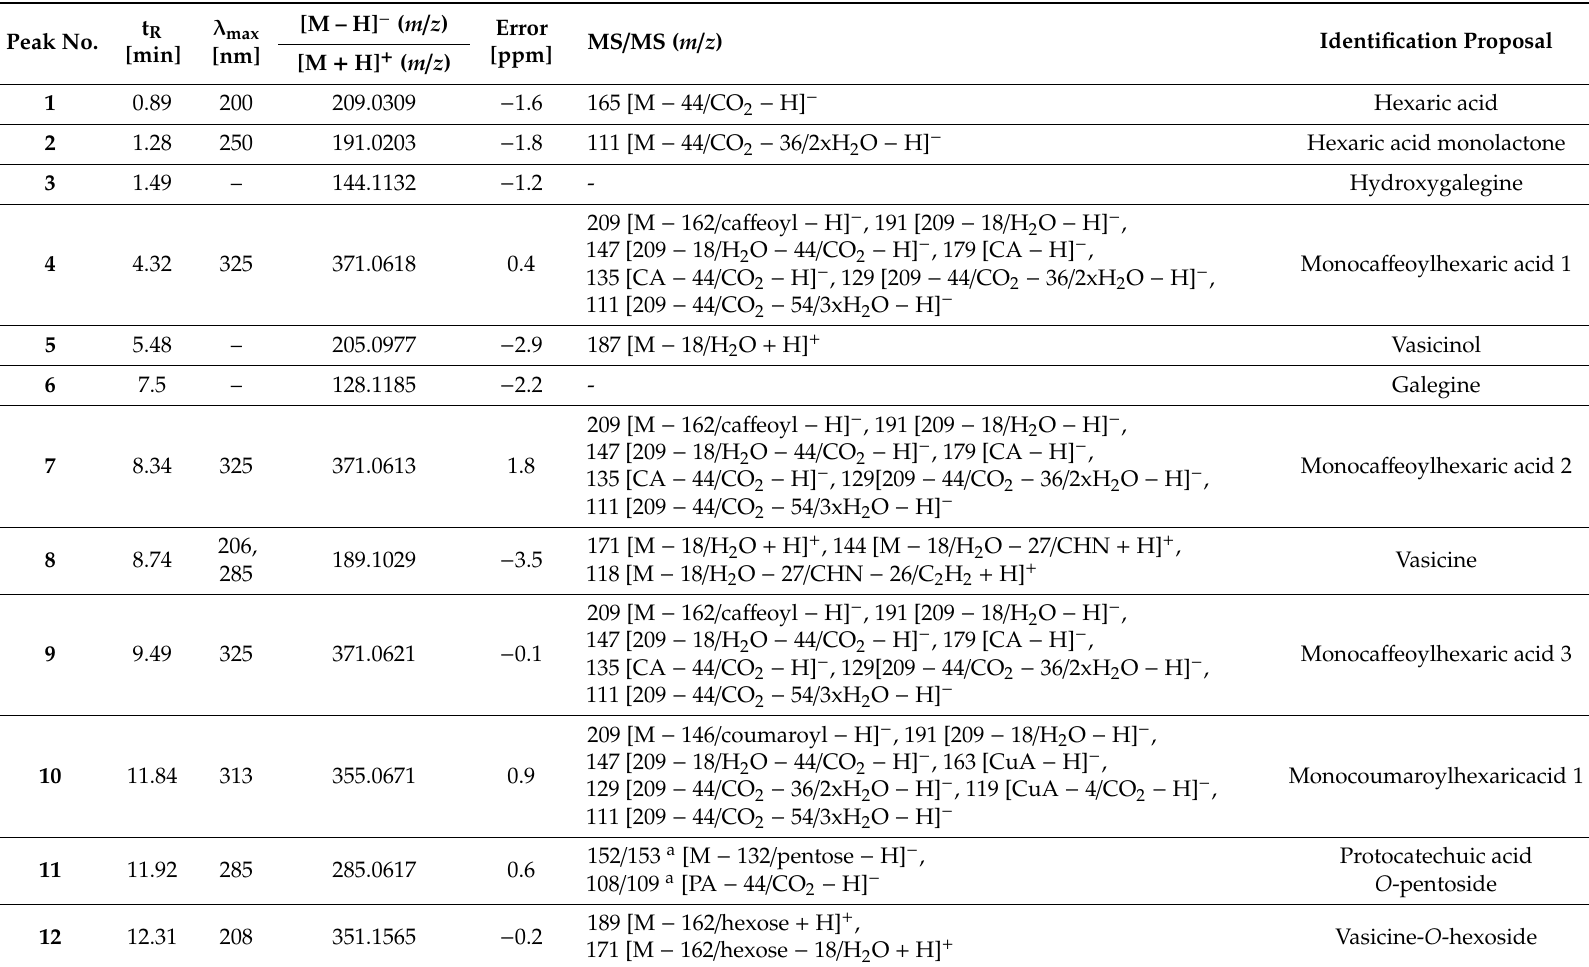
Table 1. UHPLC-ESI-MS data of G. o ffi cinalis herb components in negative and / or positive ion